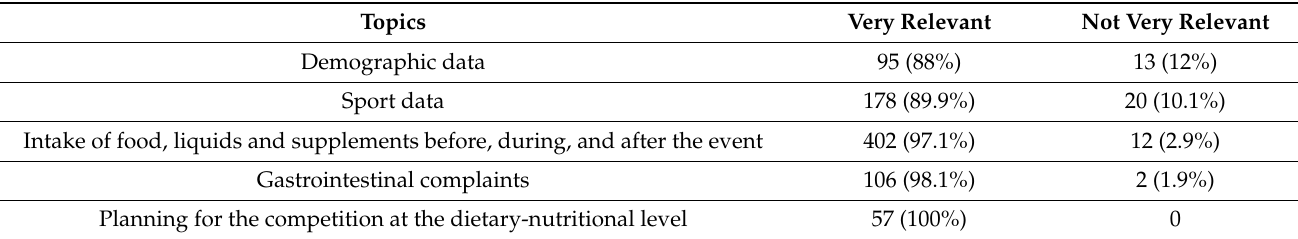
Table 6. D-N and athletes’ responses to the Delphi